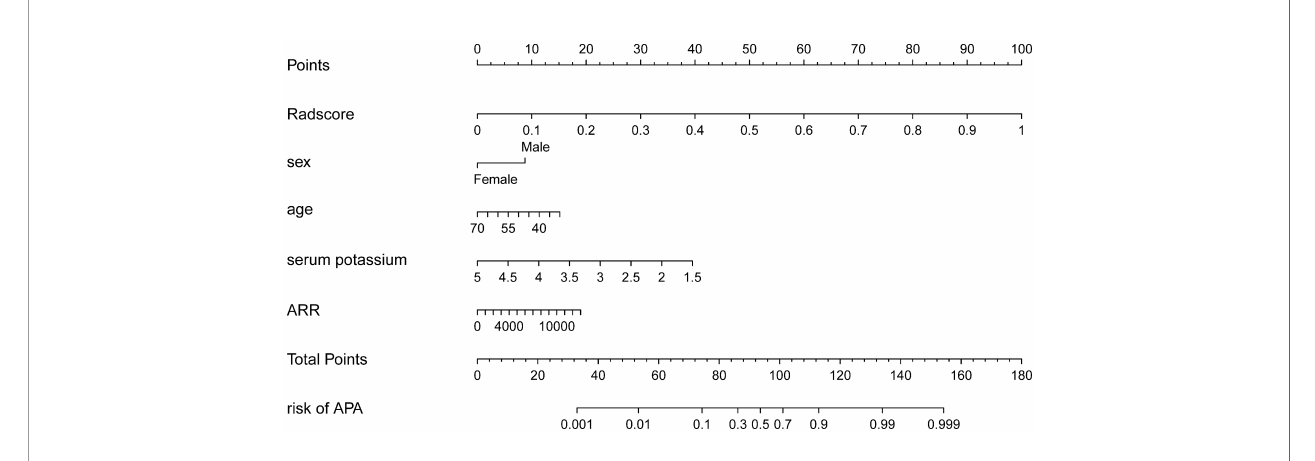
FIGURE 4 | The clinical-radiomic nomogram that was developed.